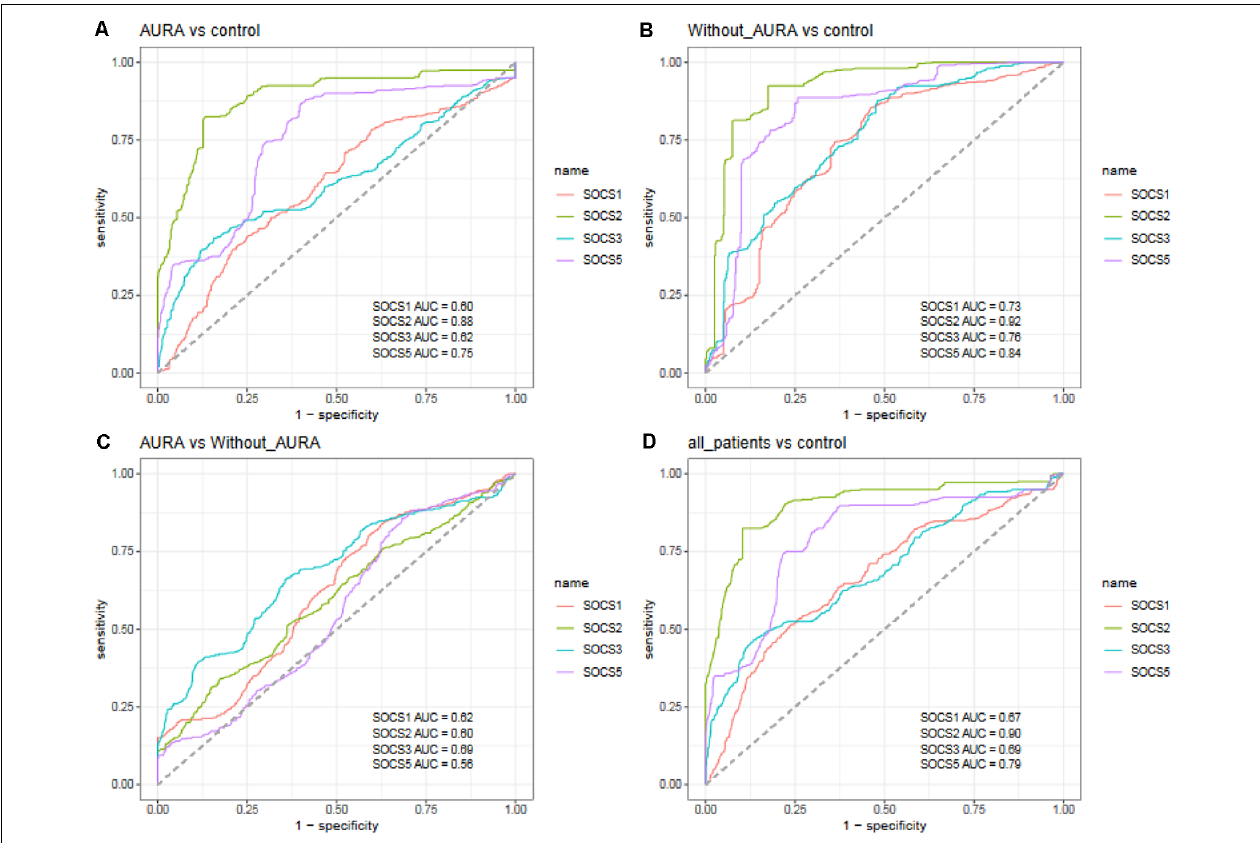
FIGURE 4 | Receiver operating characteristic (ROC) curves for assessment of the appropriateness of SOCS genes for separation of migraineurs with aura from controls (A) , migraineurs without aura from controls (B) , patients with aura from those without aura (C) , and total migraineurs from controls (D) .